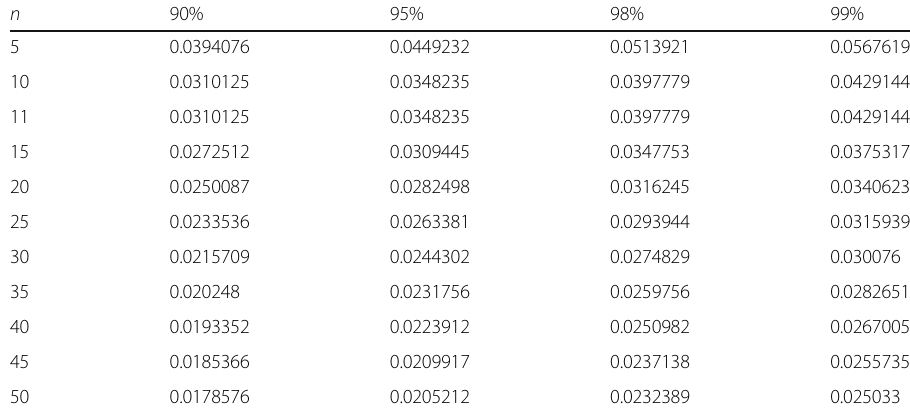
Table 2 The upper percentile of ^ Δ ð s Þ with 5000 replications at s = 2